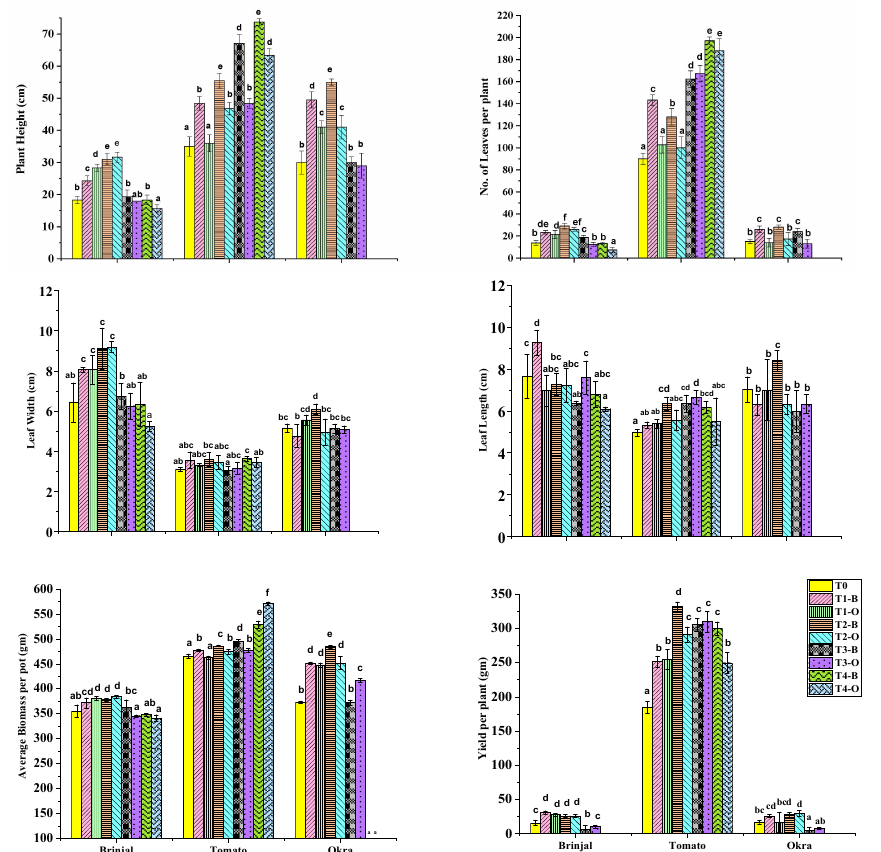
Figure 1. Morphological parameters include plant height, leaf length, leaf width, number of leaves, yield, and biomass of crops at the stage of harvesting when exposed to different concentrations of MSWC. Means with different letters are significantly different at p < 0.05. Each bar represents the mean of three replicates, and the error bars represent SD.